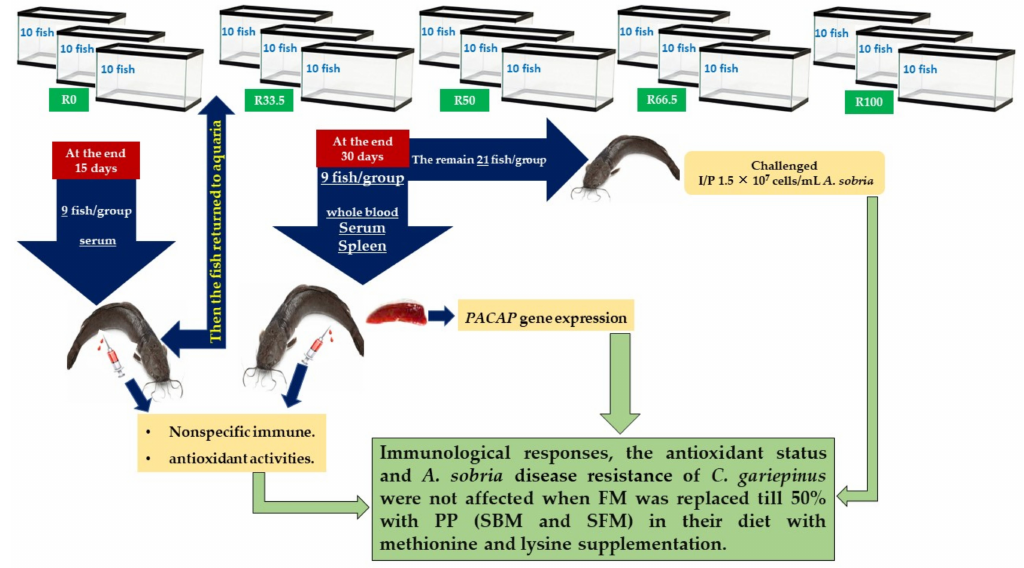
Figure 7. Summary of immunological responses and antioxidant status of Clarias gariepinus after feeding dietary fishmeal replaced by plant protein for 30 days (R0, control group = fish fed normal base diet. R33.5, R50, R66.5, and R100 = fish fed diet, with fishmeal replaced by 33.5, 50, 66.5 and 100% plant protein (soybean and sunflower meal),